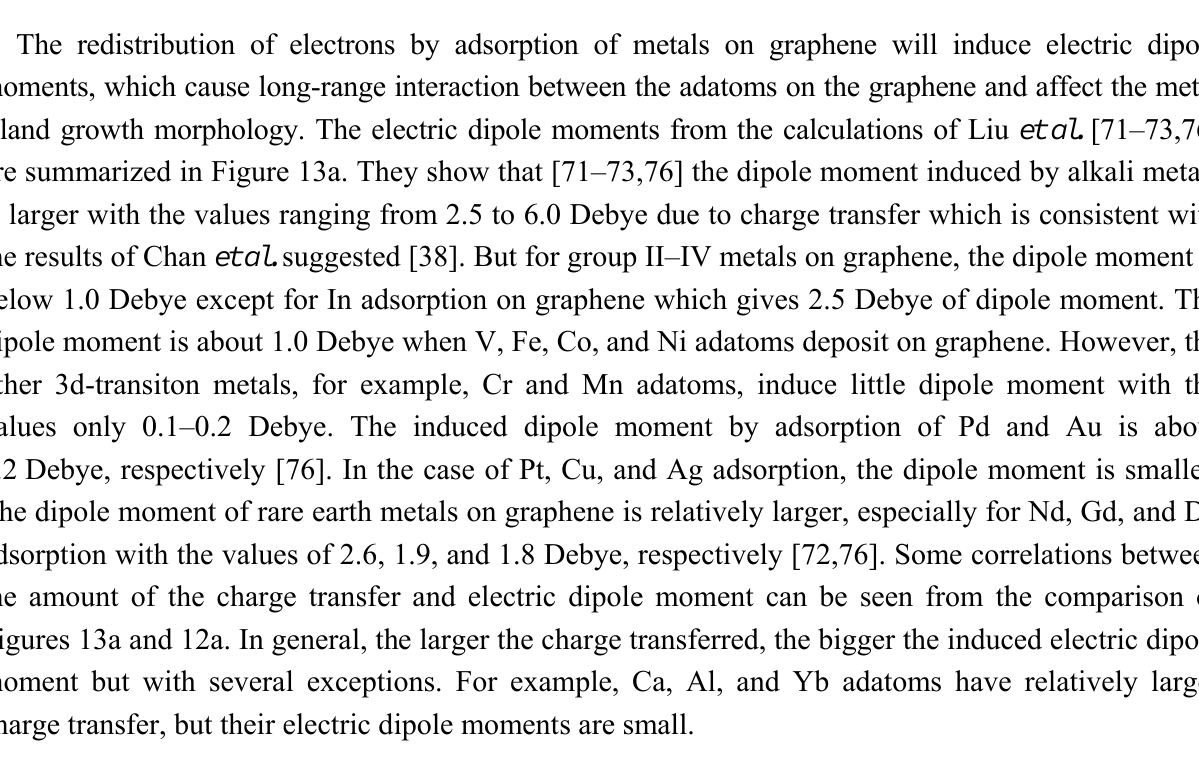
Figure 13. ( a ) Electric dipole moments; ( b ) Magnetic moment for metal/graphene system (blue bar) and isolated metal atoms (red